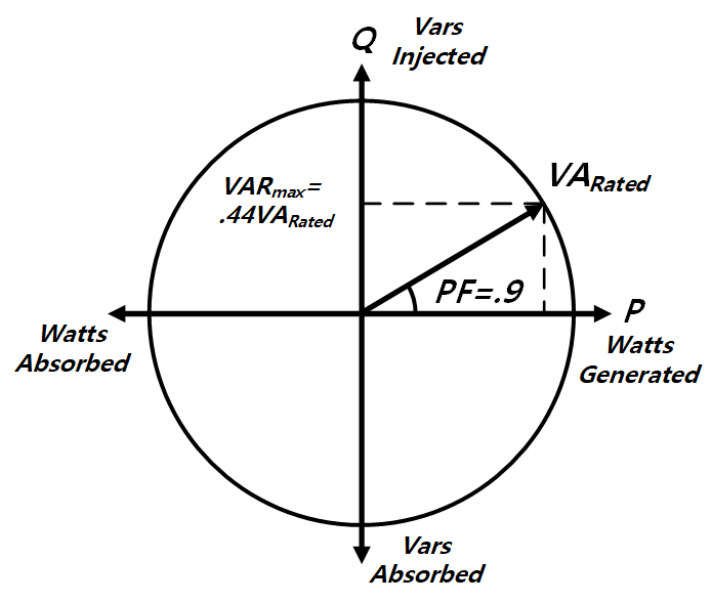
Figure 4. Determining Inverter’s Reactive Power Limit Range [18,23,29,37,38].